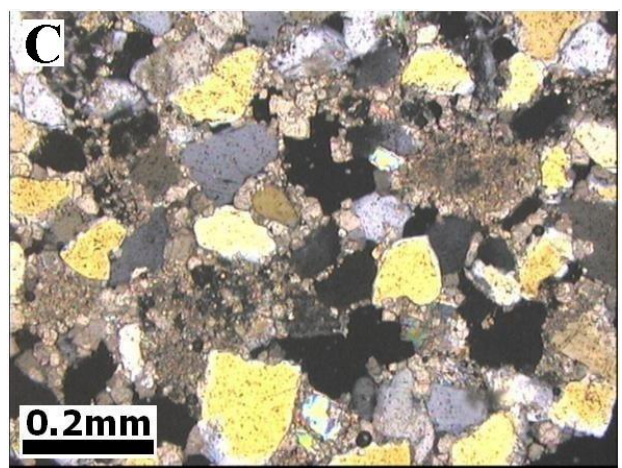
Figure 7. Sandstone with sulphated cement and co-growth